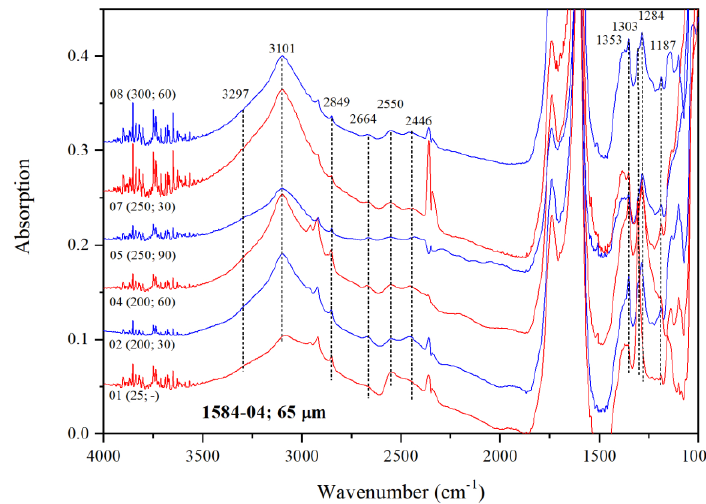
Figure 9. Unpolarized IR spectra (4000 – 1000 cm −1 ) collected on the thin section ( D -m = 65 μm) annealed at different T (200 – 300 °C) for different durations (30 – 90 min). The thin section was prepared from a low-H 2 O Mg-Rw (Crystal # 04), synthesized in Run 1584. The IR #, with the Run # and Crystal # omitted, is followed by the annealing T (°C) and annealing duration (min) in parentheses. As a comparison, the IR spectrum collected before the annealing experiments is also shown.